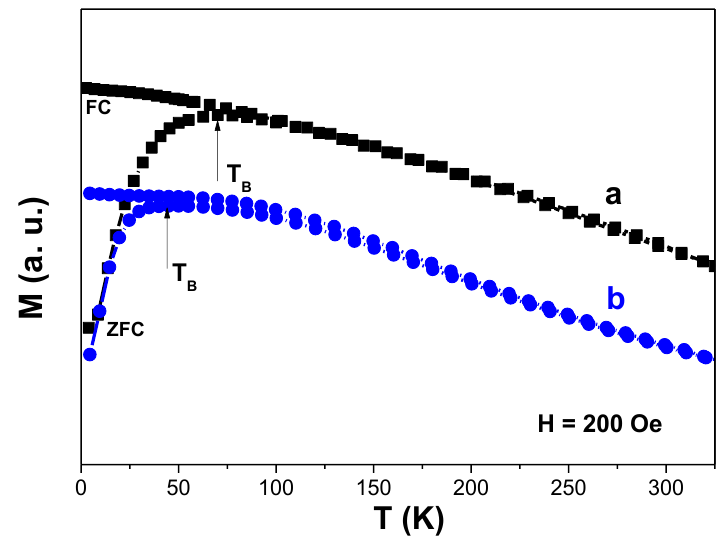
Figure 5. Variation of the magnetization as function of the magnetic field M ( H ) measured at T =310 K of ( a ) γ-Fe 2 O 3 and ( b ) β-NaY 0.8 Eu 0.2 F 4 @γ-Fe 2 O 3 particles.